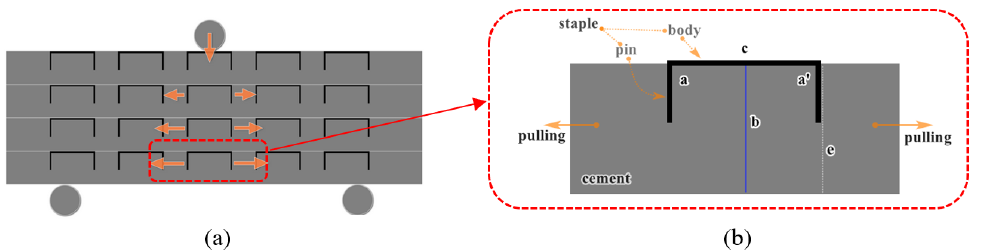
Figure 16. Simple models of the reinforcements. ( a ) Stapled beam under three-point bending test and ( b ) staple over the interface.